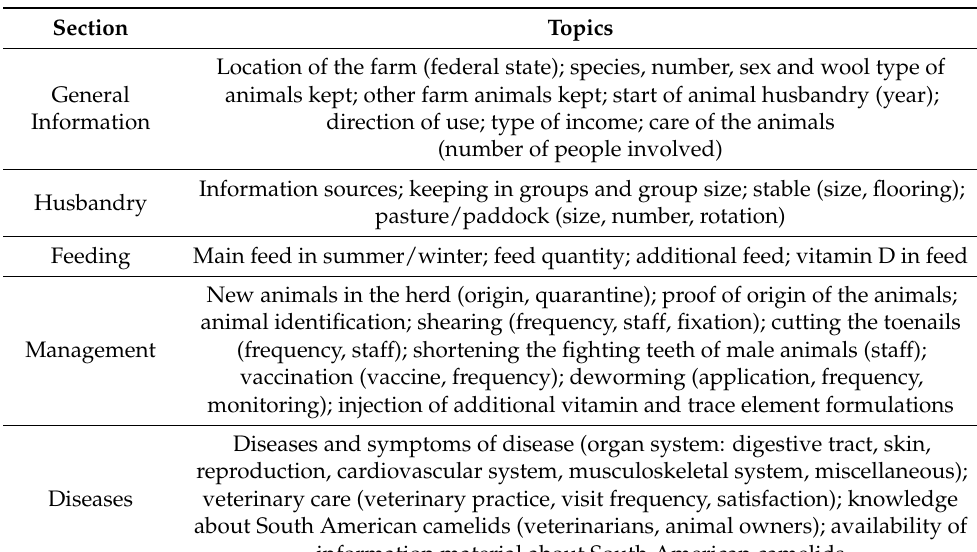
Table 1. Summary of the topics covered by the